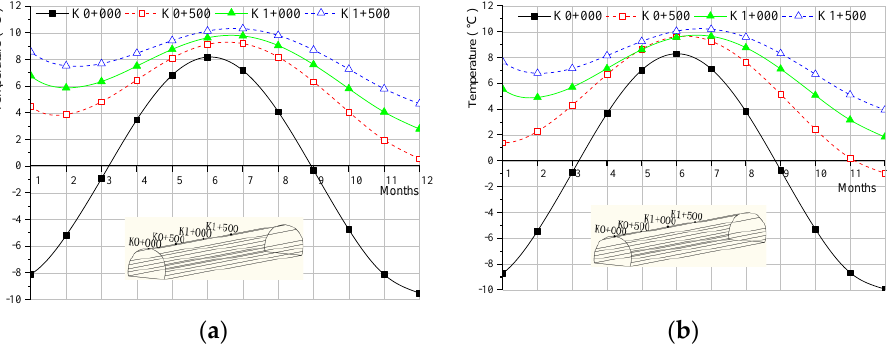
Figure 10. Monthly average airflow temperature curves on the tunnel vault surface in the entrance section: ( a ) without heat-insulating layer and ( b ) with heat-insulating layer.